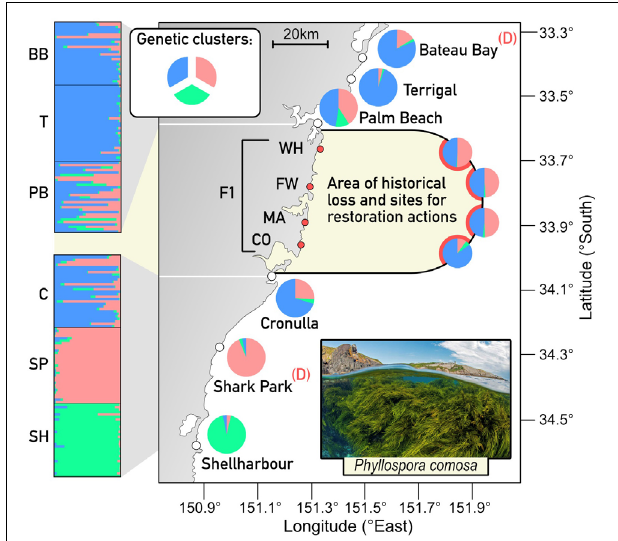
FIGURE 2 | Restoration of crayweed ( P. comosa ) at four sites within the 70 km gap in distribution where it was locally extinct (shaded area), was informed by genetic structure of six extant surrounding populations. Restored sites were a mix of plants from two donor populations (D) and the resulting F1 generation mimicked natural, extant genetic baselines. Adapted from Wood et al. (in